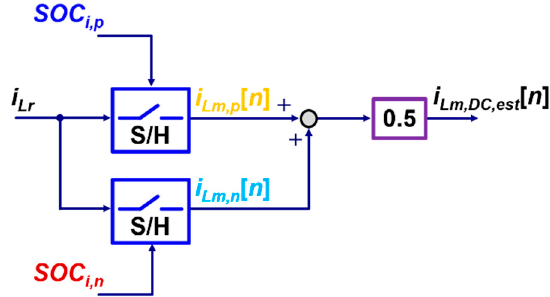
Figure 10. Block diagram of the magnetizing DC current estimator.